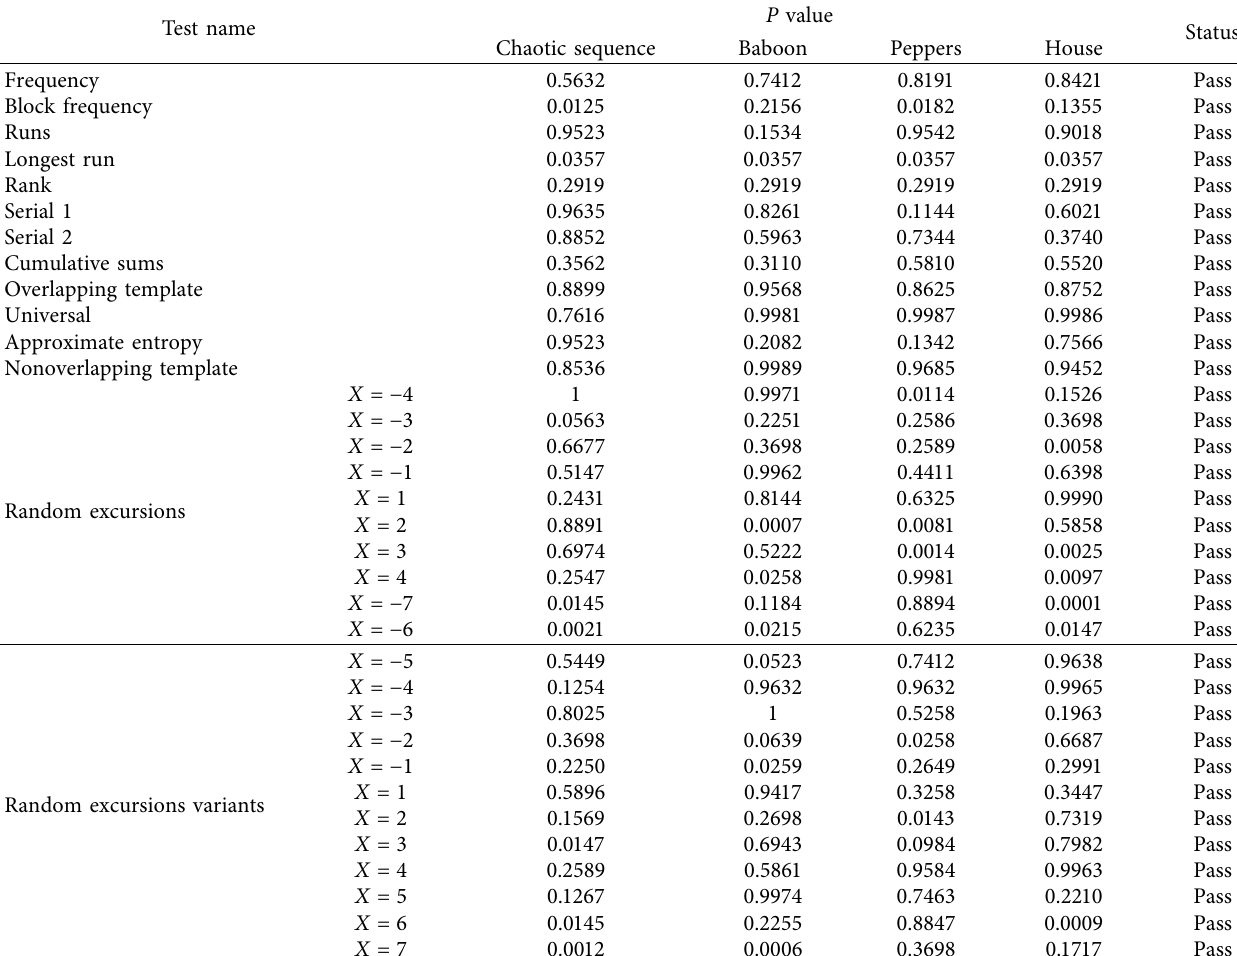
Table 5: NIST measures for chaotic map and different standard color images.